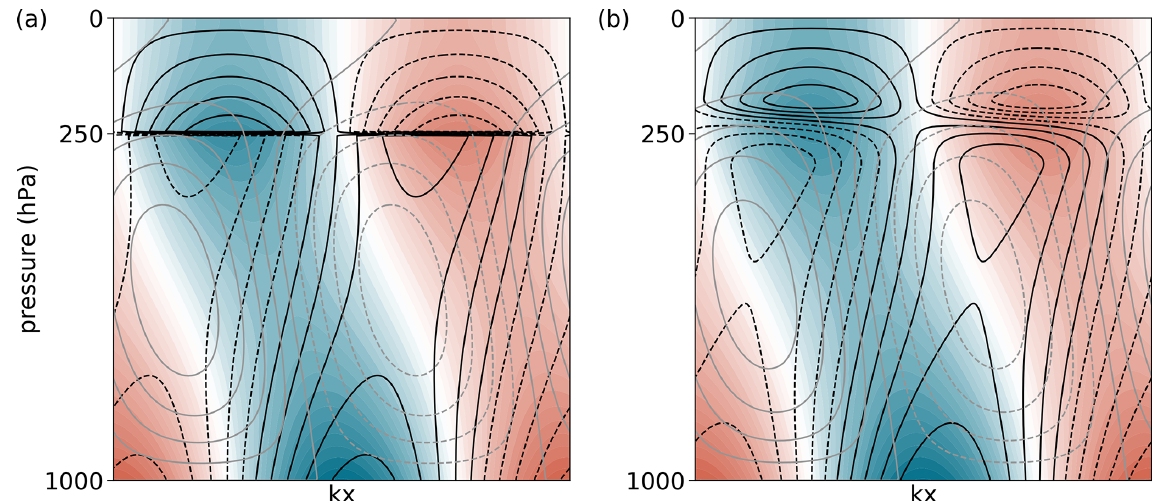
Figure 3. Structure of ψ (shading), − ∂ψ/∂p (black contours), and ω (grey contours) for (a) the sharp CTL experiment and (b) the smooth CTL experiment. Values are not comparable to physical values due to normalisation constraint mentioned in Sect.